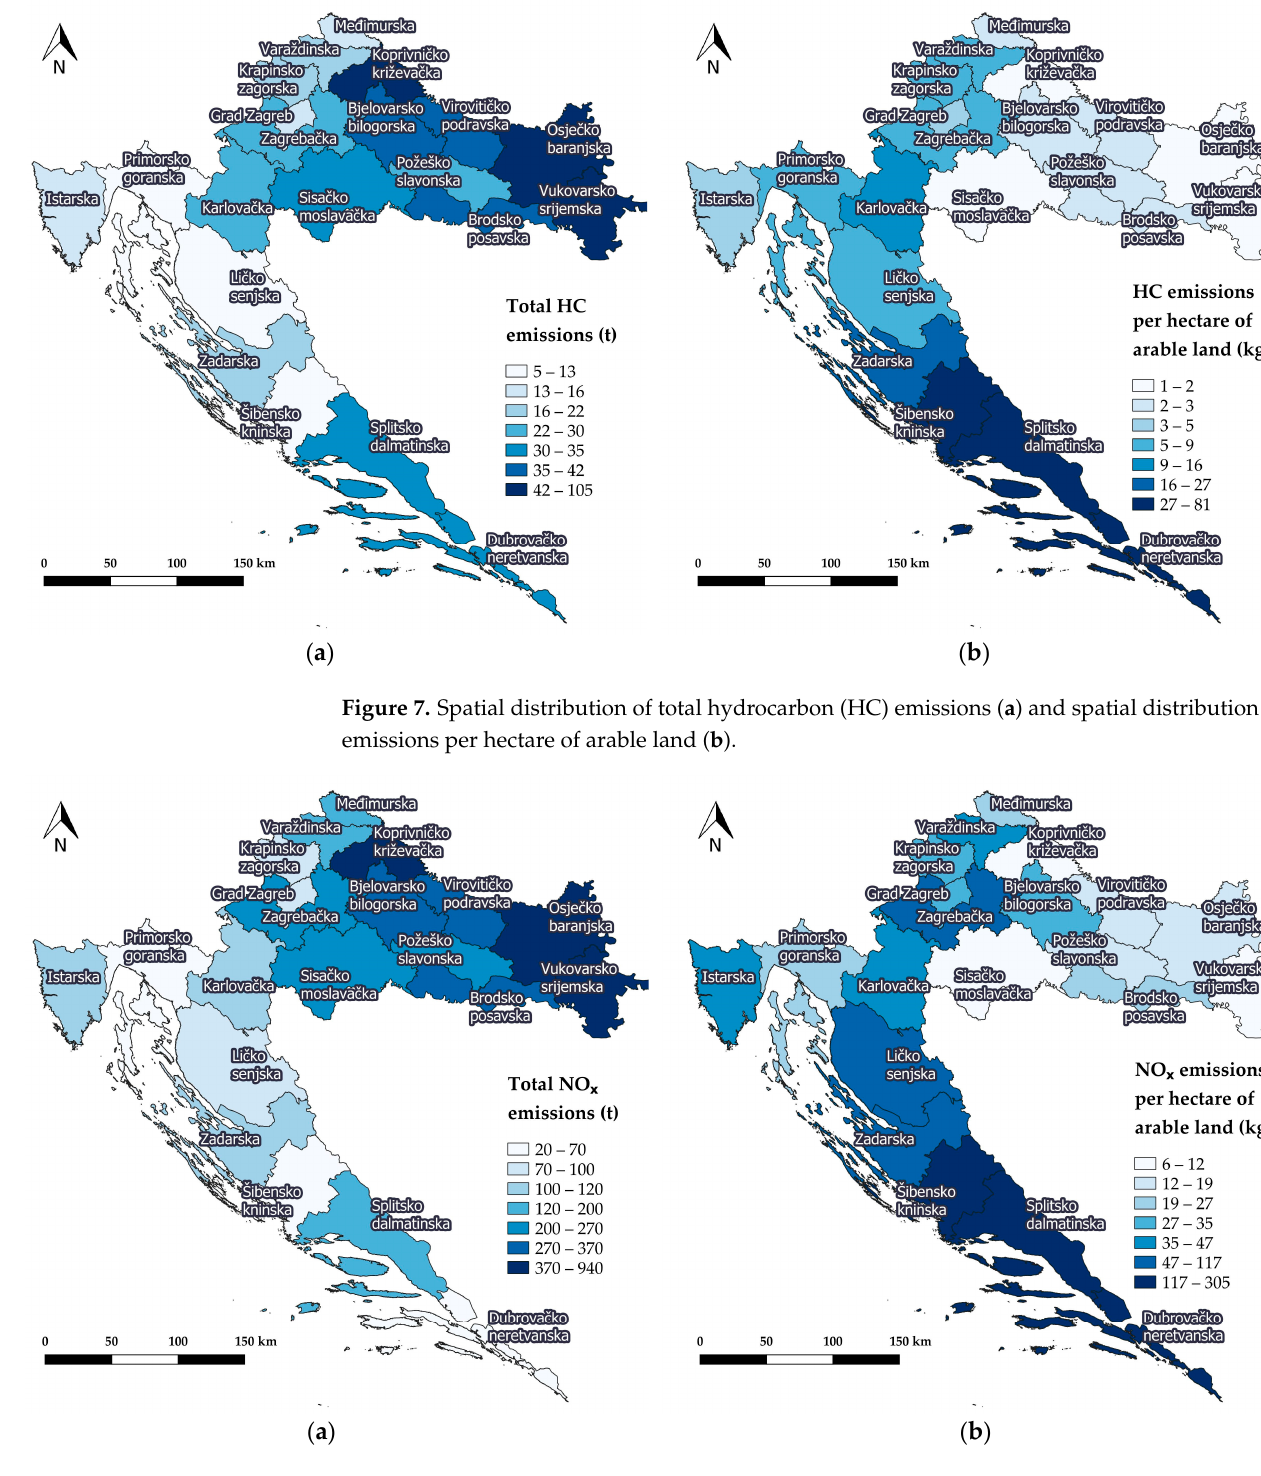
Figure 8. S patial distribution of total nitrogen oxide (NO X ) emissions ( a ) and spatial distribution of NO X emissions per hectare of arable land ( b ).